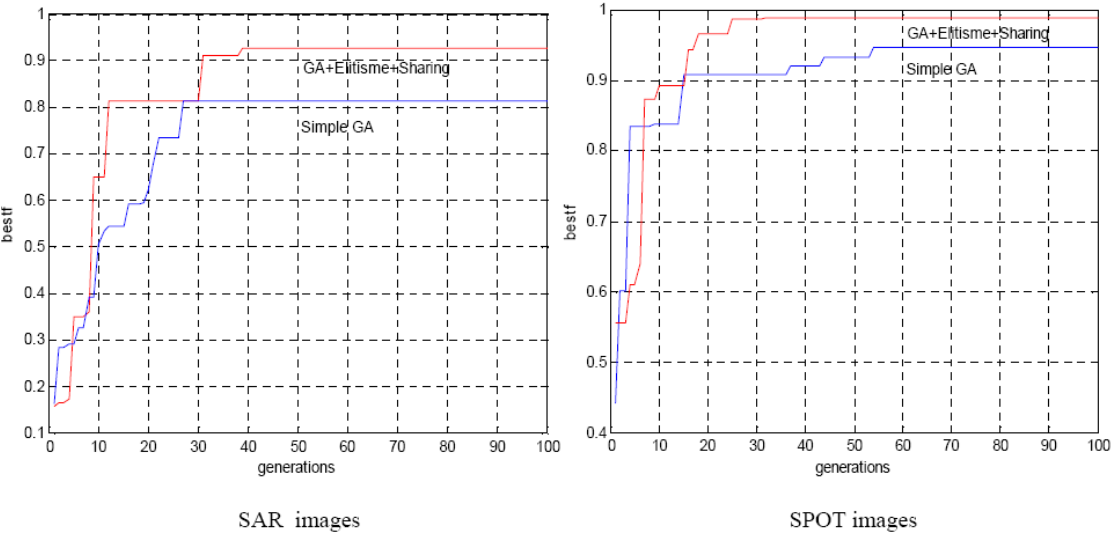
Figure 5. Evolution of best solution during the run of